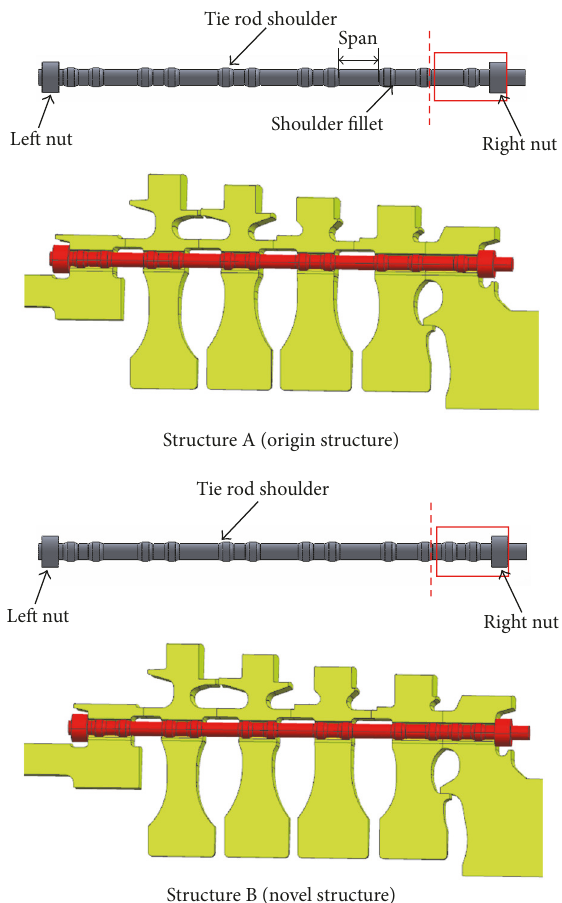
Figure 23: Two kinds of turbine tie rod structure.